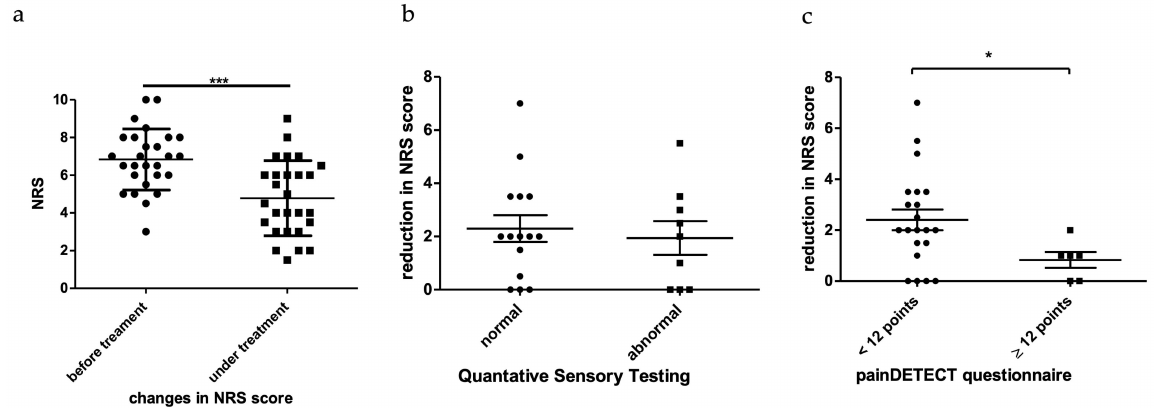
Figure 3. ( a – c ). NRS evaluation. ( a ) Response to therapy with carbamazepine. Patients were asked to score their pain levels before and under carbamazepine treatment. The NRS level was significantly lower under treatment. ( b ) NRS reduction did not correlate with QST results. The y-axis depicts the change in NRS before and under treatment. There was no significant difference in pain reduction between patients with normal and abnormal QST results. ( c ) NRS reduction correlated with painDETECT-scores. The y-axis depicts the change in NRS before and after treatment. Pain reduction was significantly greater in patients with a normal painDETECT questionnaire ( p < 0.05) than in patients, whose questionnaire showed unclear results or results indicative of neuropathic pain. Stars denote the level of significance with * p < 0.05; *** p <